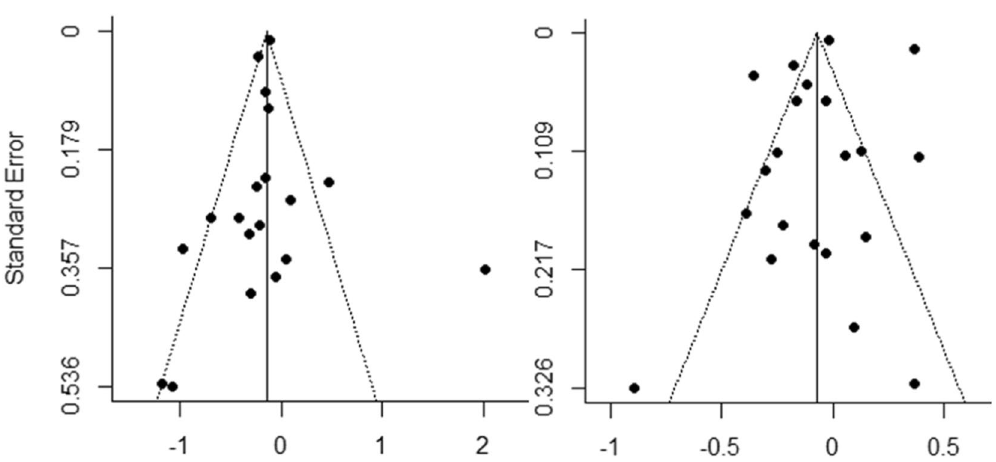
Figure 4. Funnel plot of risk ratio versus standard error for the association between thiazide use and fracture risk. ( a ) For case-control studies. ( b ) For cohort